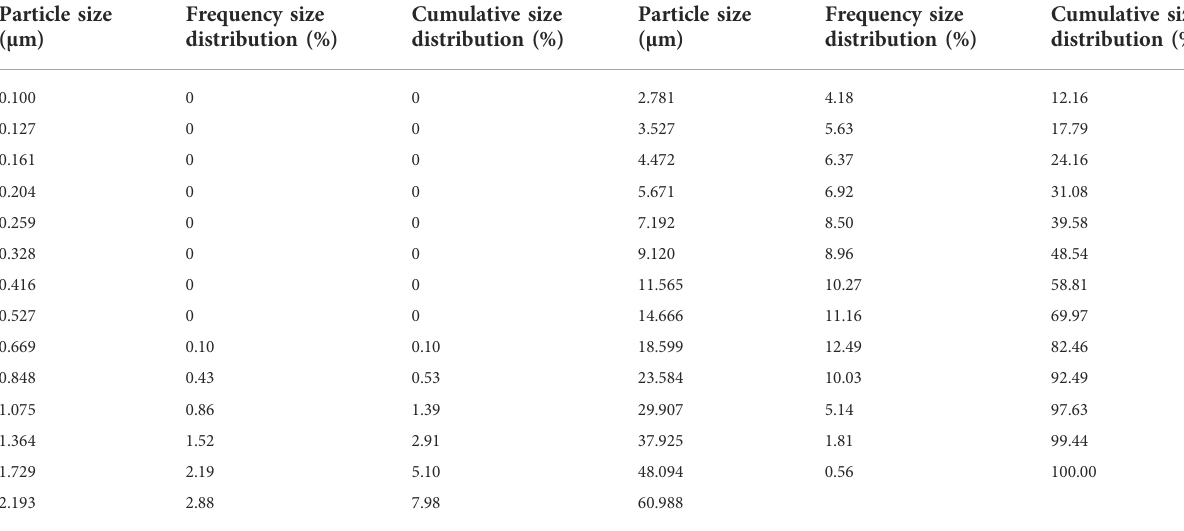
TABLE 1 Particle size distribution of K600 super fi ne